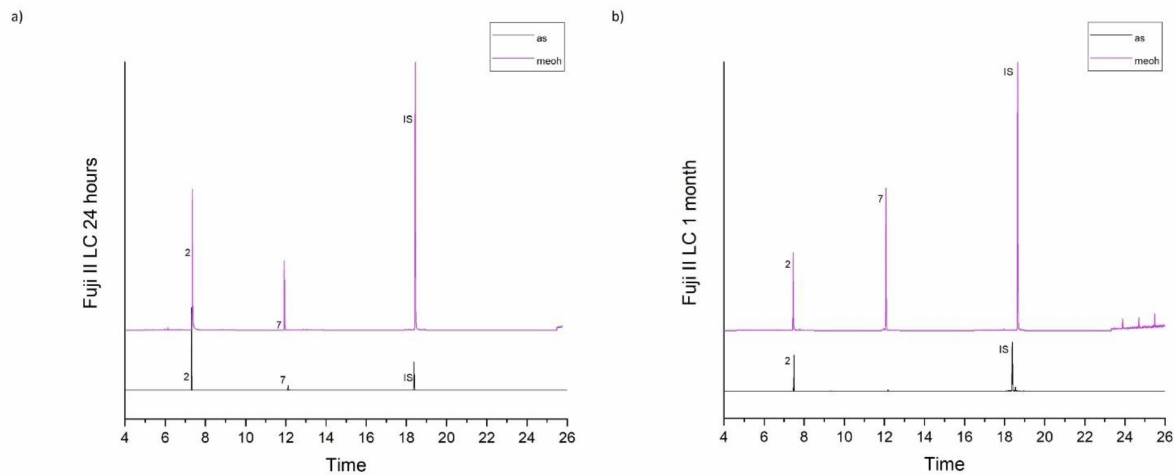
Figure 4. ( a , b ). CChromatograms of Fuji II LC in artificial saliva and methanol for both observation periods (24 h and 1